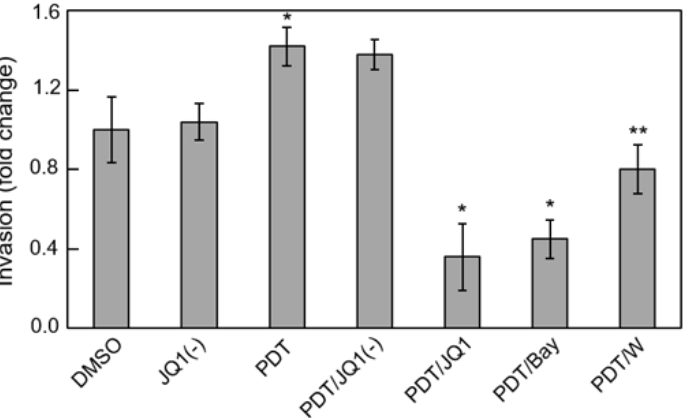
Figure 4. JQ1 abrogation of photostress-enhanced glioblastoma cell invasiveness. U251 cells at ~60% confluency were pre-incubated with 1 mM ALA. After PDT irradiation (1 J/cm 2 ), these cells, along with dark controls, were harvested and assessed for invasiveness in the absence vs. presence of 0.3 µ M JQ1, 0.3 µ M JQ1( − ), 5 µ M Bay11, or 25 µ M 1400W. DMSO served as a vehicle control for JQ1 and JQ1( − ). Cells crossing Matrigel-infused filters after an incubation period of 24 h were pelleted and quantified by CCK-8 assay. Plotted invasion values are means ± SEM ( n = 3); * p < 0.001 vs. PDT; ** p < 0.01 vs. PDT. Reproduced from Reference [61], with permission.